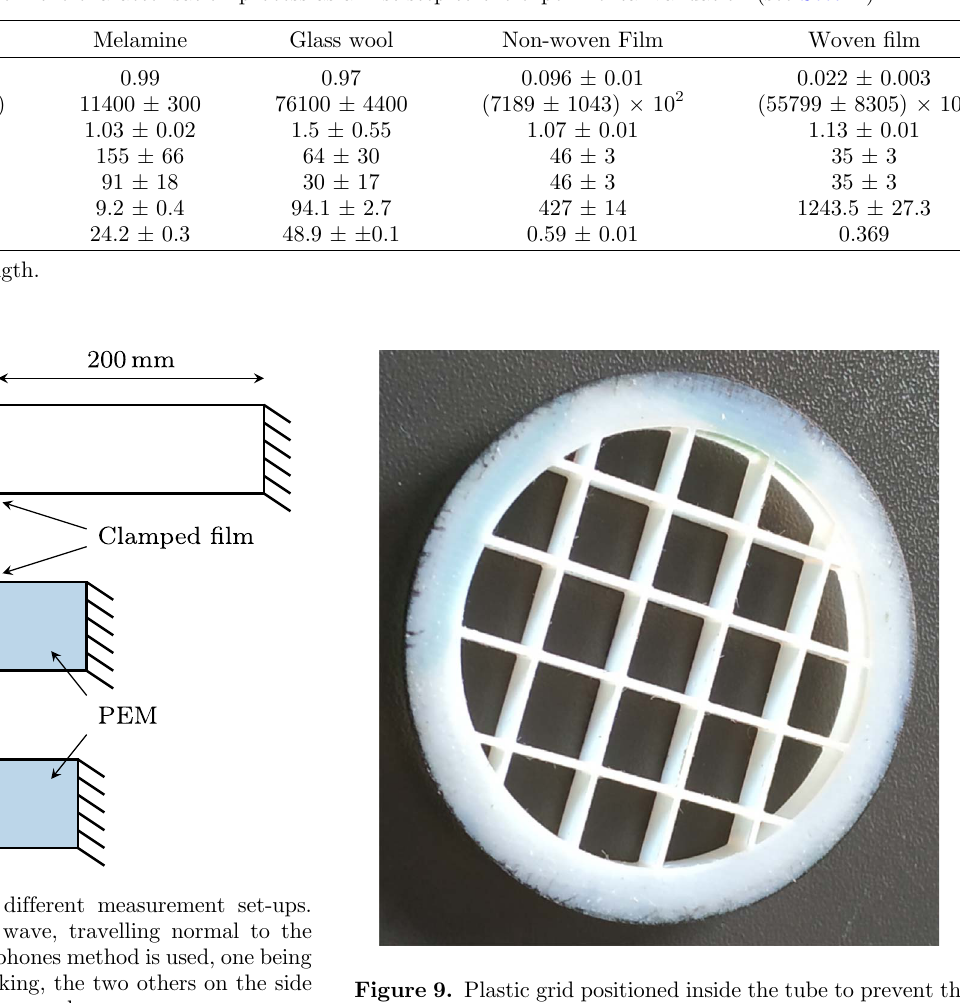
Figure 9. Plastic grid positioned inside the tube to prevent the facings from bending. It adds a 0.89 mm shift due to its